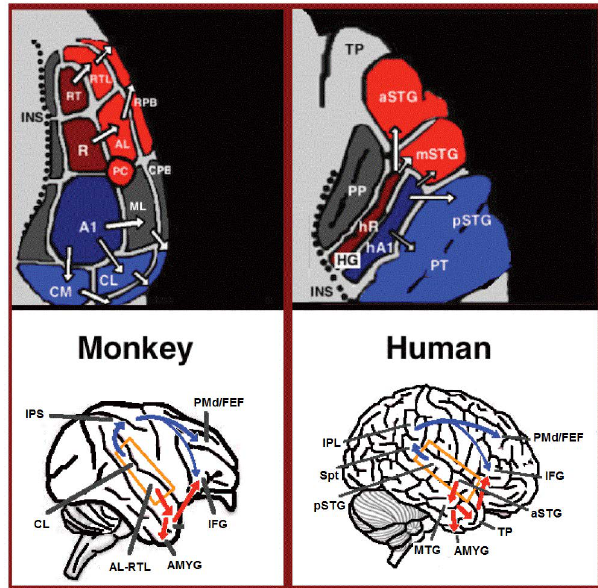
Figure 1. Dual stream connectivity between the auditory cortex and frontal lobe of monkeys and humans. Top: The auditory cortex of the monkey (left) and human (right) is schematically depicted on the supratemporal plane and observed from above (with the parieto- frontal operculi removed). Bottom: The brain of the monkey (left) and human (right) is schematically depicted and displayed from the side. Orange frames mark the region of the auditory cortex, which is displayed in the top sub-figures. Top and Bottom: Blue colors mark regions affiliated with the ADS, and red colors mark regions affiliated with the AVS (dark red and blue regions mark the primary auditory fields). Abbreviations: AMYG-amygdala, HG-Heschl’s gyrus, FEF-frontal eye field, IFG-inferior frontal gyrus, INS-insula, IPS-intra parietal sulcus, MTG-middle temporal gyrus, PC-pitch center, PMd-dorsal premotor cortex, PP-planum polare, PT-planum temporale, TP-temporal pole, Spt-sylvian parietal-temporal, pSTG/ mSTG/aSTG-posterior/middle/anterior superior temporal gyrus, CL/ ML/AL/RTL-caudo-/middle-/antero-/rostrotemporal-lateral belt area, CPB/RPB-caudal/rostral parabelt